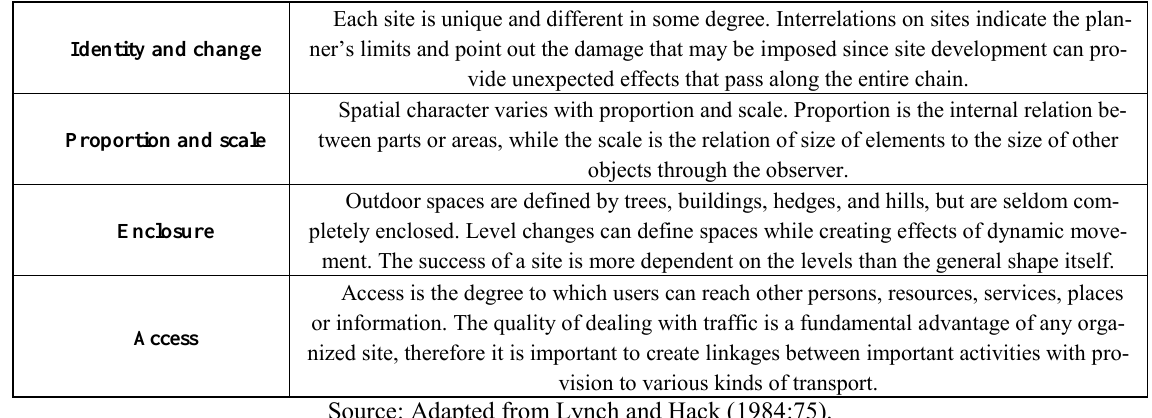
Table 3: Lynch and Hack’s spatial planning principles for the best practice city